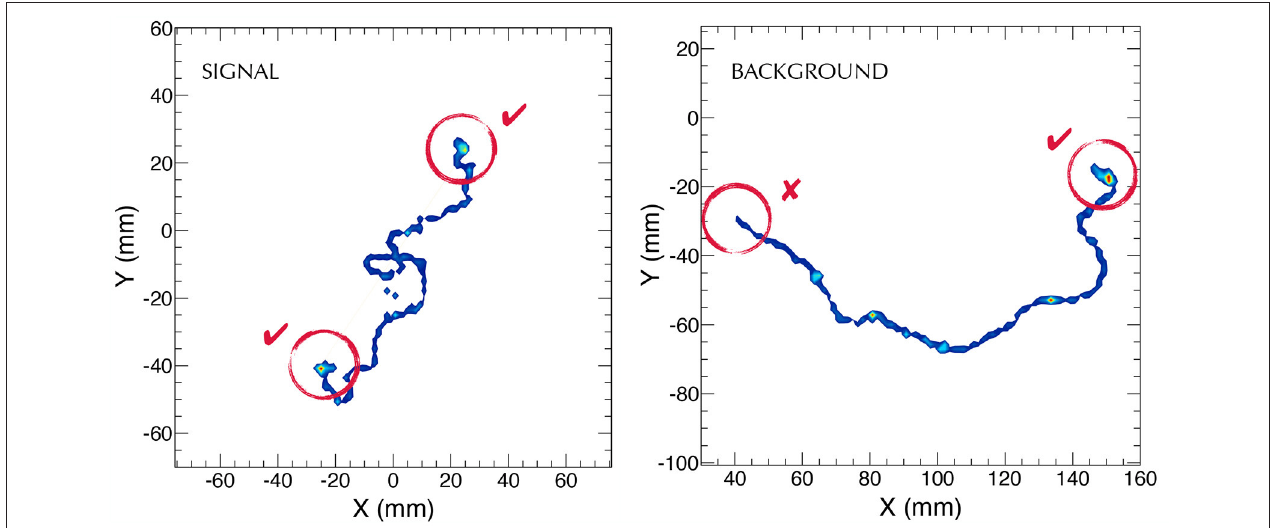
FIGURE 4 | The left panel shows two electrons emitted in a ββ 0 ν decay propagating in HPXe with perfect track reconstruction; the right panel shows a single background electron produced by a photoelectric interaction from a 214 Bi gamma of energy very close to Q ββ . While the energy of the background electron could enter the ROI, the two topologies are different. A ββ 0 ν event results in two electrons which are ended in two areas of denser energy depositions as the electron deposits suddenly its energy near the end-of-the-ionization path (Bragg peak). In the case of a background electron there is only a single area of higher energy density. Figure from Martín-Albo et al. [